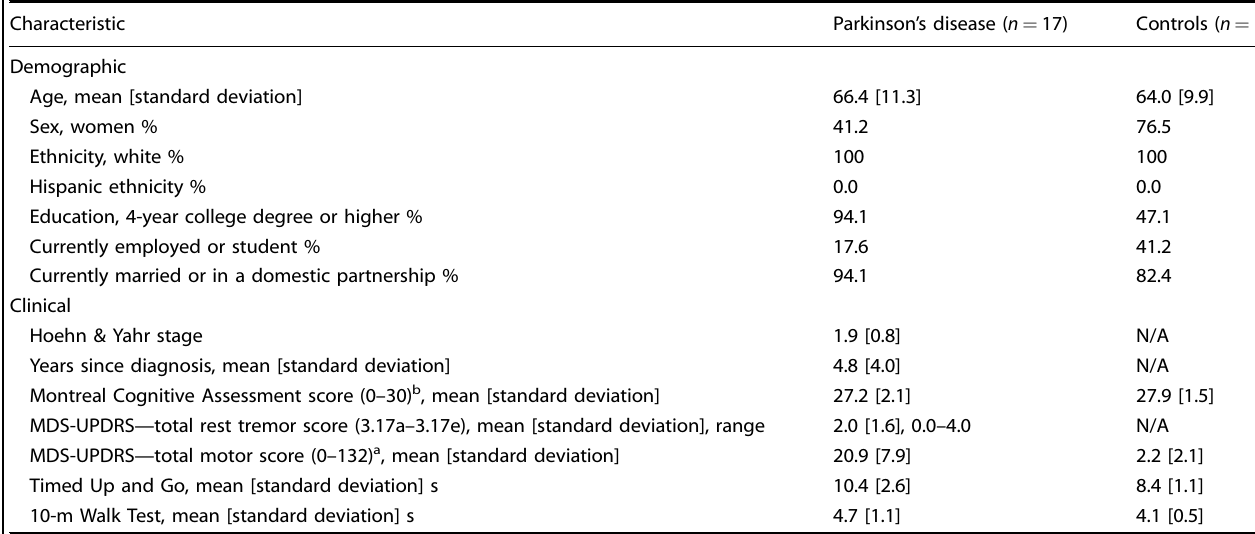
Table 1. Characteristics of the study population.